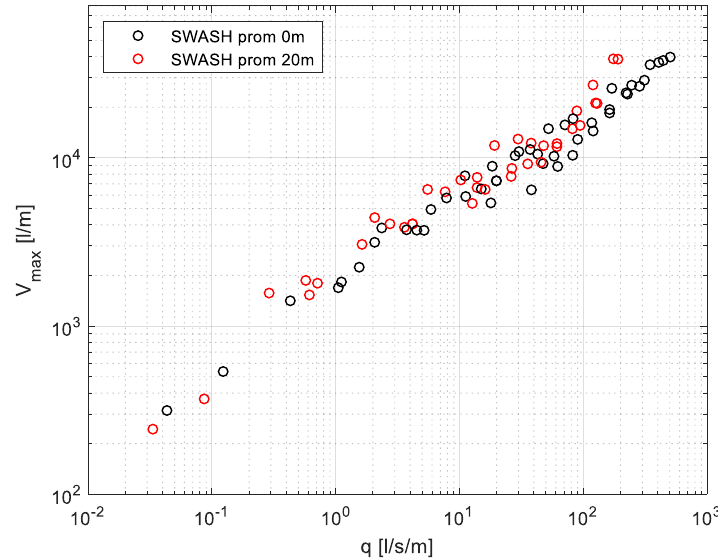
Figure 4. Comparison between promenade width 0 m and 20 m on q-V max (Average overtopping discharge - maximum individual overtopping volume).